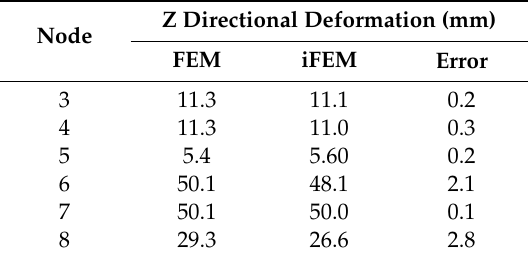
Table 1. Results of nodes deformation.